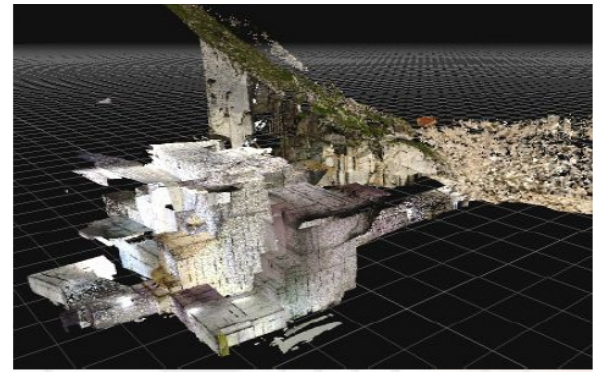
Figure 2 . TLS 3D Point Cloud of a marble quarry (underground).